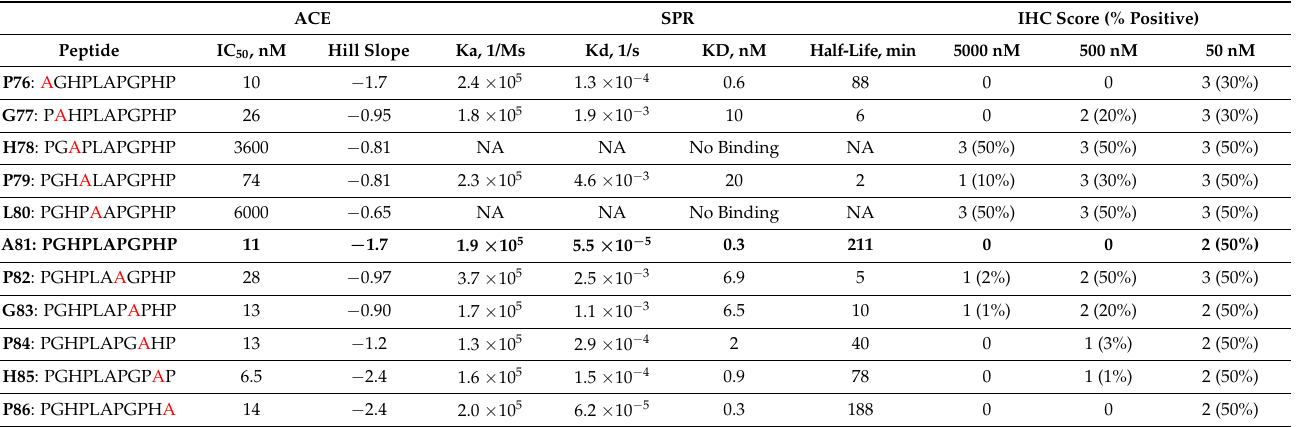
Table 1. Effect of alanine substitution on the SP464 epitope binding parameters as measured by ACE, SPR, and